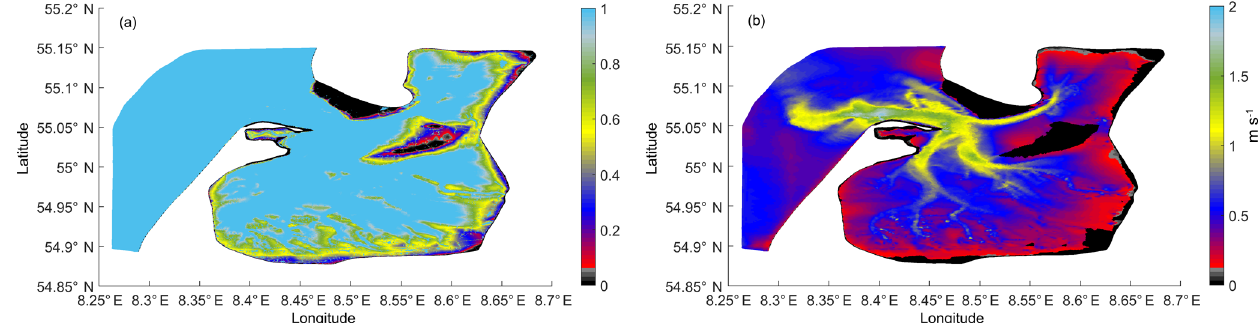
Figure 3. (a) The probability of wetting based on simulations of the two full tidal cycles using the unstructured grid. (b) The peak tidal velocities at the current position using the unstructured